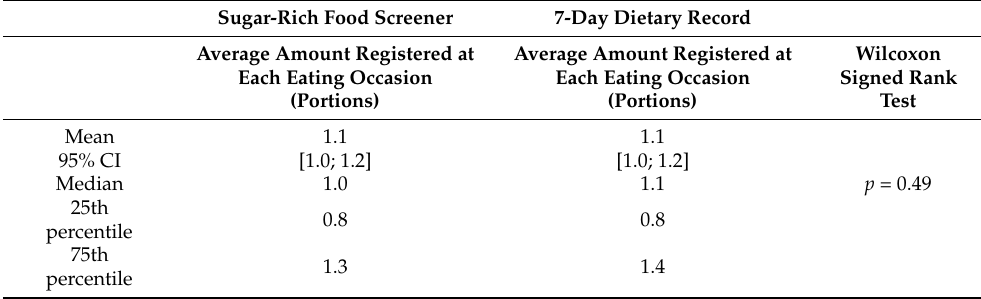
Table 5. Mean portion size of registered intakes of discretionary foods and drinks (portions of 450 kJ) in the SRFS and the 7-day dietary record ( n =